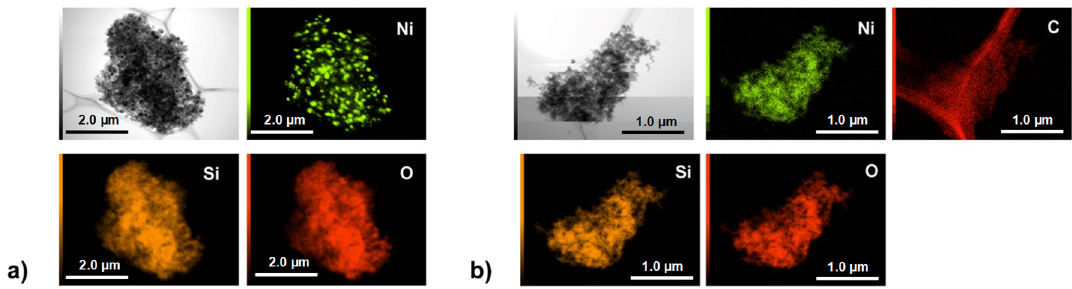
/ SiO / SiO 2 and ( b ) Ni-C 2